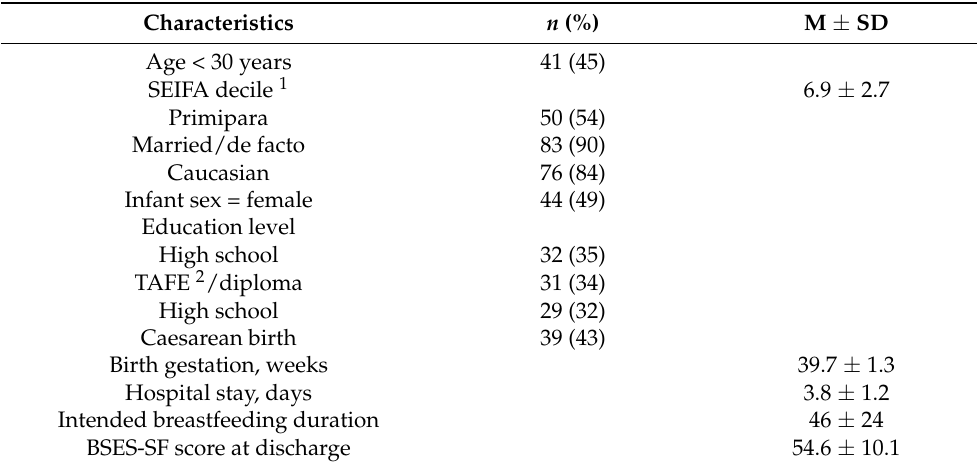
Table 1. Maternal demographic and background feeding